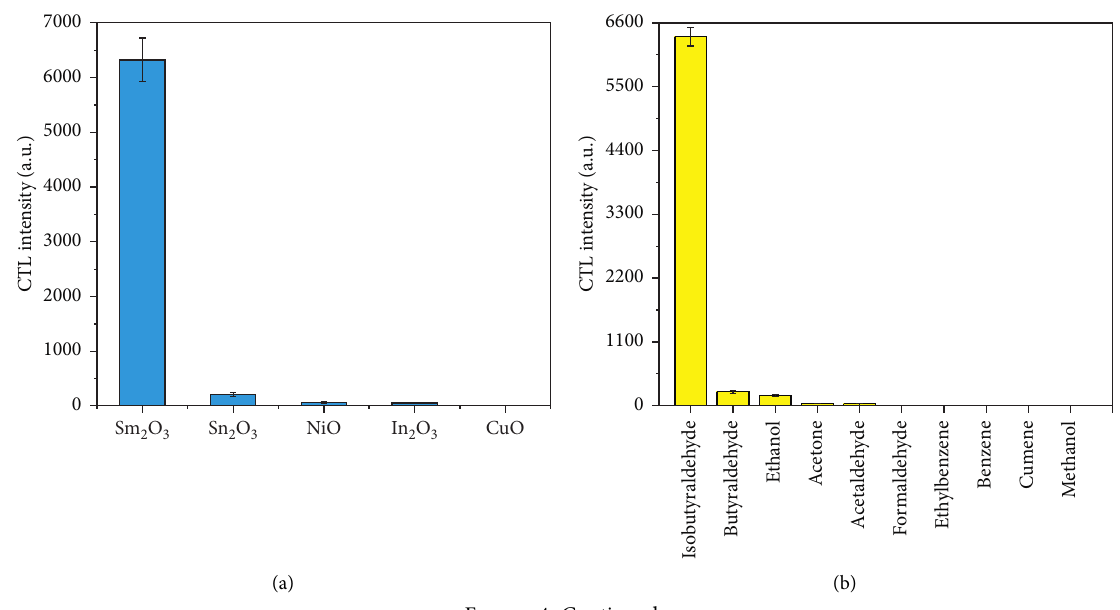
2 O 3 ; (b) XRD pattern of nano-Sm 2 O 3